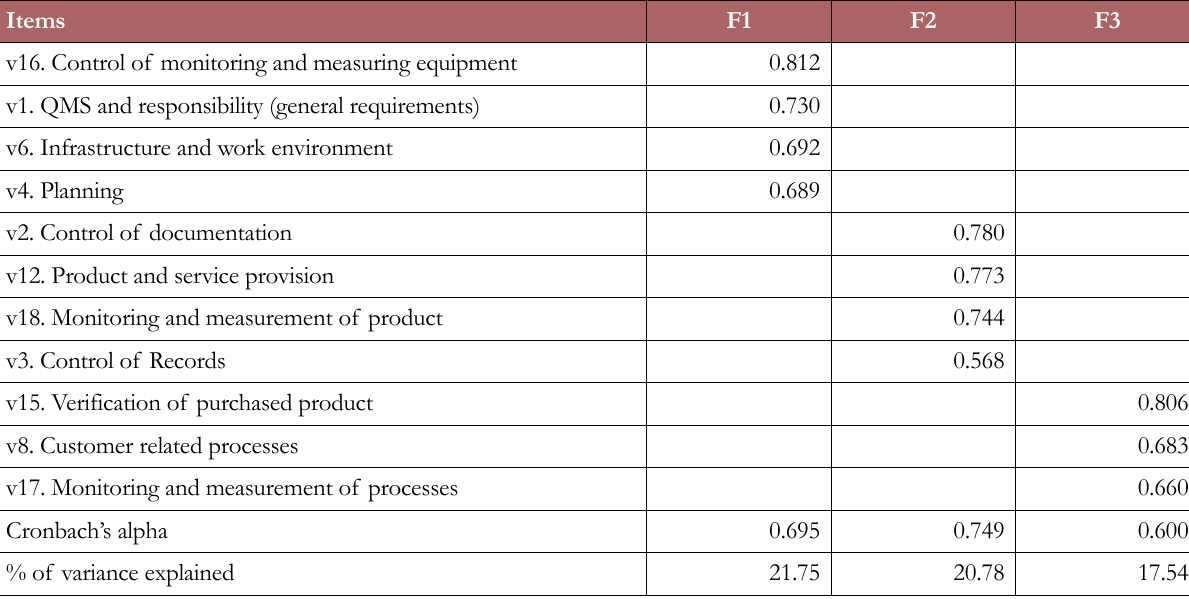
Table 5. Matrix rotated components using the Varimax extraction